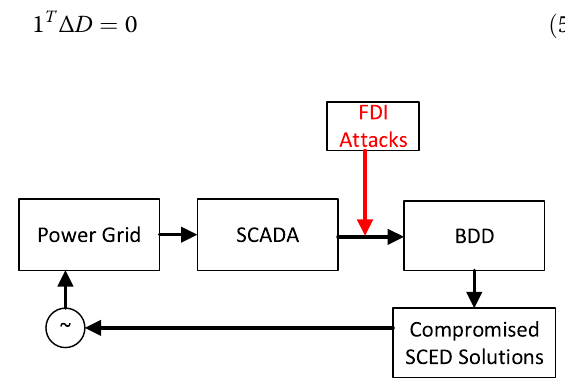
Fig. 2 Illustration of FDI attacks on economic